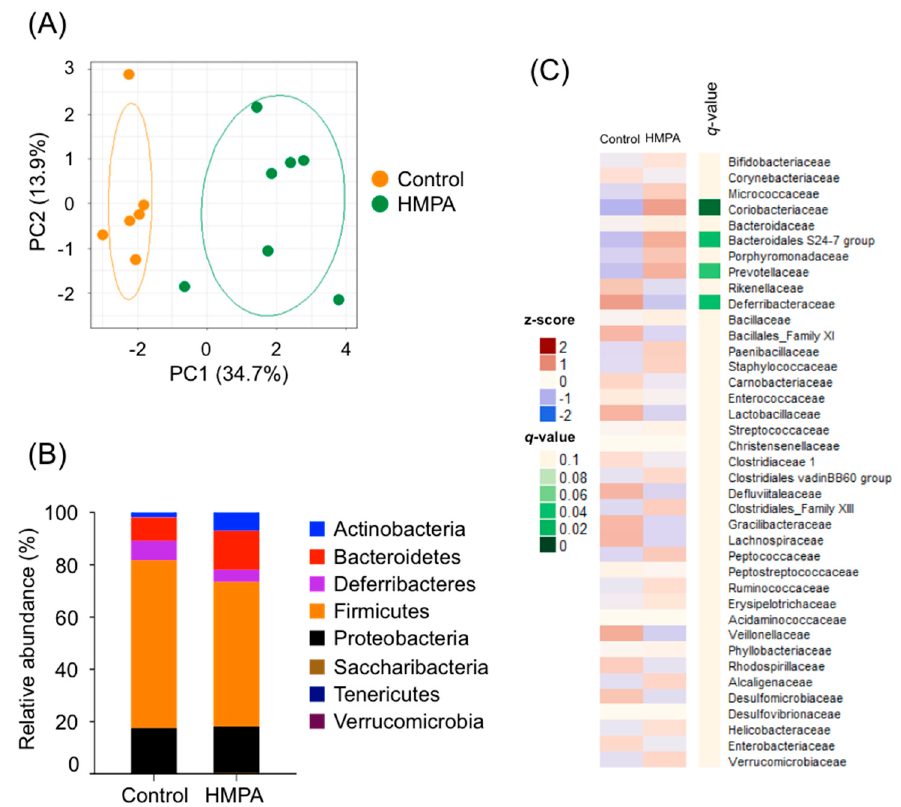
Figure 4. Compositions of gut microbiota in the HMPA-supplemented HFD-fed mice compared to the HFD controls. ( A ) PCoA of the cecal microbiota in HMPA-supplemented HFD-fed mice vs. the